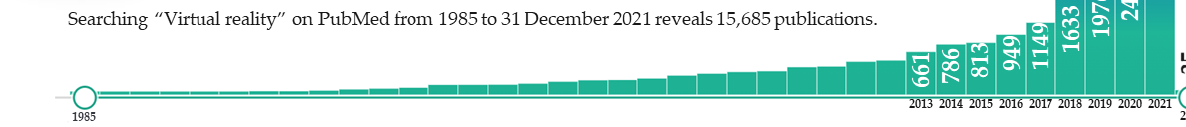
Figure 1. Virtual reality (VR) equipment and yearly publication trends from 1985 to 2022.